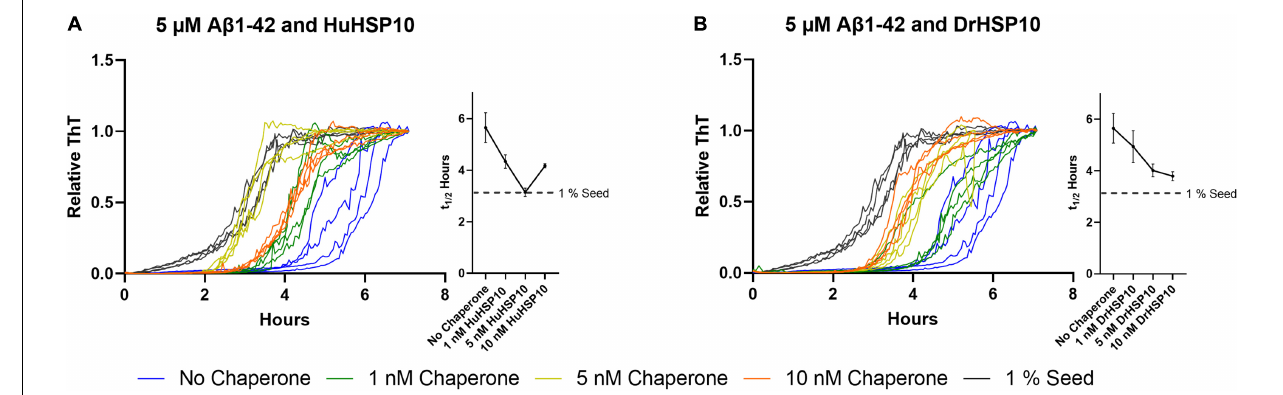
FIGURE 7 | Normalized ThT traces of A β 1–42 fibrillation (5 µ M) when chaperones are present at low concentrations as well as A β 1–42 fibrillated in the presence of 1% preformed fibril seeds. Traces are colored according to the legend in the figure. Corresponding halftimes of fibril conversion, t 1 / 2 (hours), for each concentration are shown to the right in each panel. (A) A β 1–42 and HuHSP10 and (B) A β 1–42 and DrHSP10. In this concentration interval, both HuHSP10 and DrHSP10 accelerate the fibrillation of A β 1–42 compared with the spontaneous fibrillation of A β 1–42 alone. The assay was conducted in quiescent conditions at 37 ◦ C in non-treated 96-well